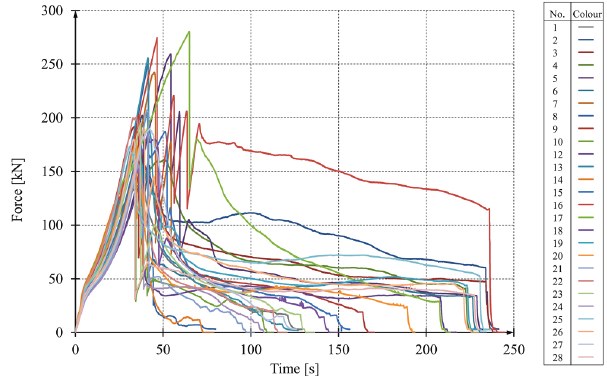
Fig. 7. Changes of load transferred by pile-concrete specimen anchorage